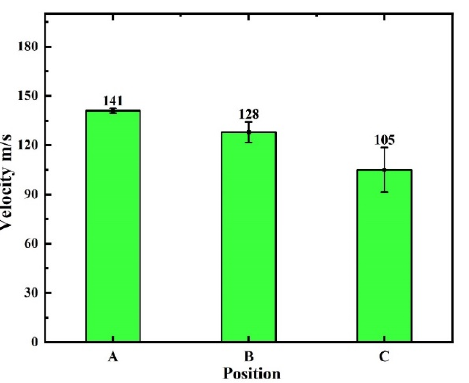
Figure 9. A schematic diagram of simulation results for the special ‐ shaped hot forging. ( a ) Iso ‐ sur ‐ face view of the high ‐ pressure water jets; ( b ) Cross ‐ sectional view of the high ‐ pressure water jets; ( c ) Cross ‐ sectional view of the high ‐ pressure water jet in the middle. ( c ) Cross-sectional view of the high-pressure water jet in the middle.